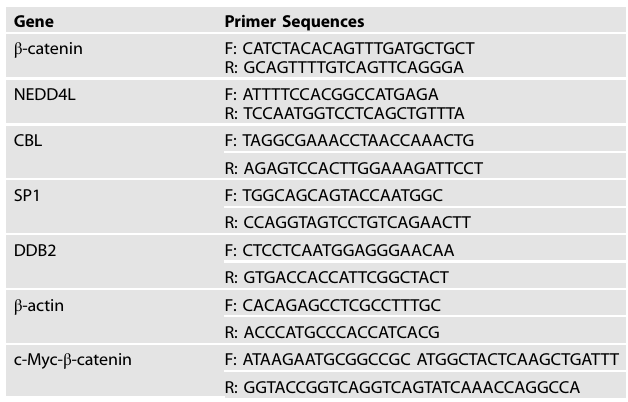
Table 1. Primers sequences used in the